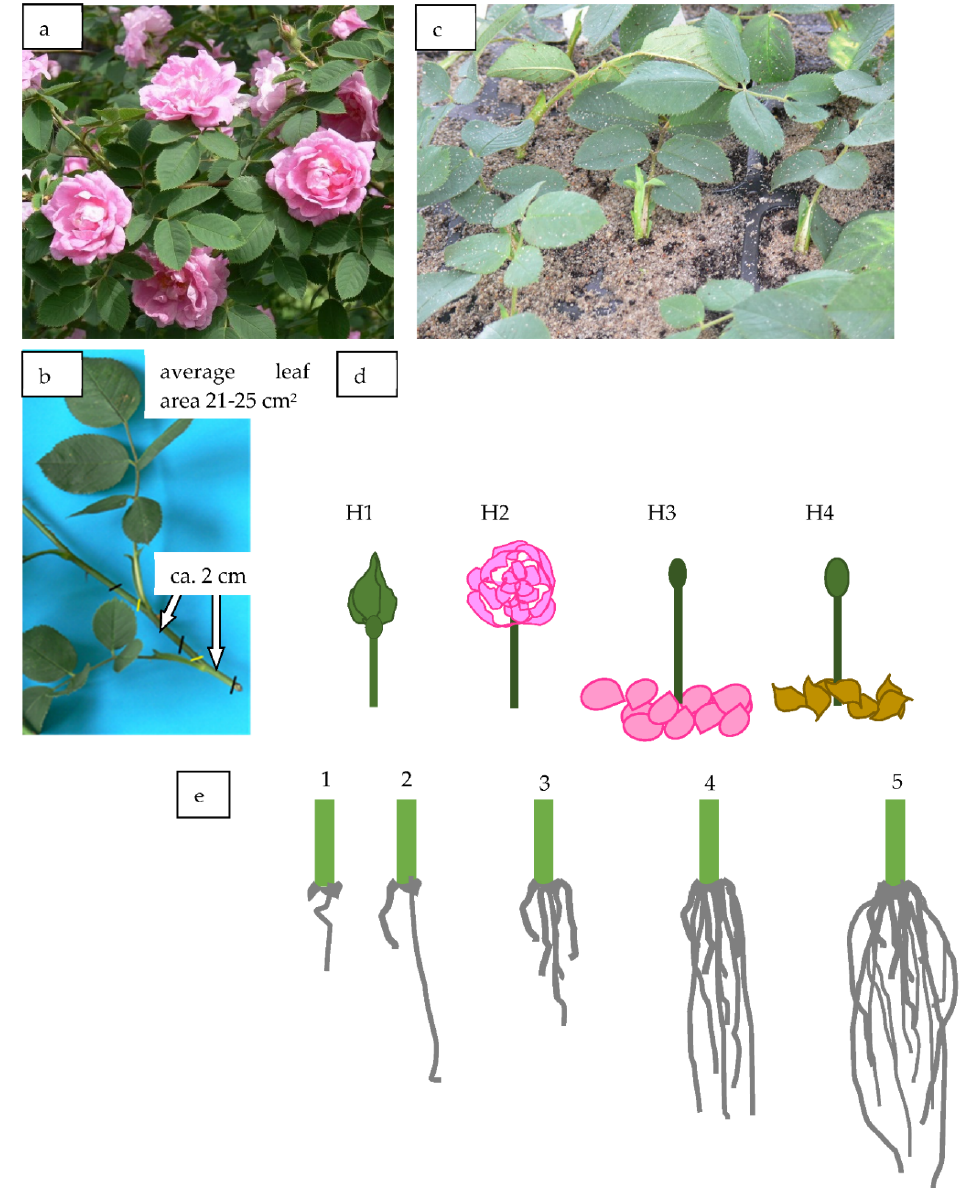
Figure 1. The Rosa ‘Hurdal’ ( a ); single-node leaf cutting prepared for experiment ( b ); planted cuttings ( c ); phenological stages of shoots for cuttings’ preparation, as they figure in this work named and in BBCH scale (Meier et al. 2009) ( d ): H1—flower buds closed (BBCH 54 504; flower buds still closed); H2—flowers opened (69 605; full flowering, at least 50% of flowers open); H3—immediately after petal shedding (69 629; end of flowering of second order stem: all petals fallen); H4—7 × 14 days after shedding petals (70 701; fruit set: beginning of hip berry − growth on the main stem); ( e ) the quality of the root system (degree of rooting) on a 5-point valuation scale: 1—only callus, without formed roots; 2—at least one short root; 3—a few longer roots; 4—roots visibly developed, differentiated by length; 5—strong roots, starting to form a root ball, well developed. Stages (Figure 1d) according to BBCH scale in roses [13] lasted 16 days and are denoted in the work by the letter H: H1—27 May, 54 504 (flower buds still closed), H2—1 June, 69 605 (full flowering; at least 50% of flowers open), H3—6 June, 69 629 (end of flowering of second order stem: all petals fallen), H4—11 June, 70 701 (fruit set: beginning of berry growth on the main stem) (Figure 1d).